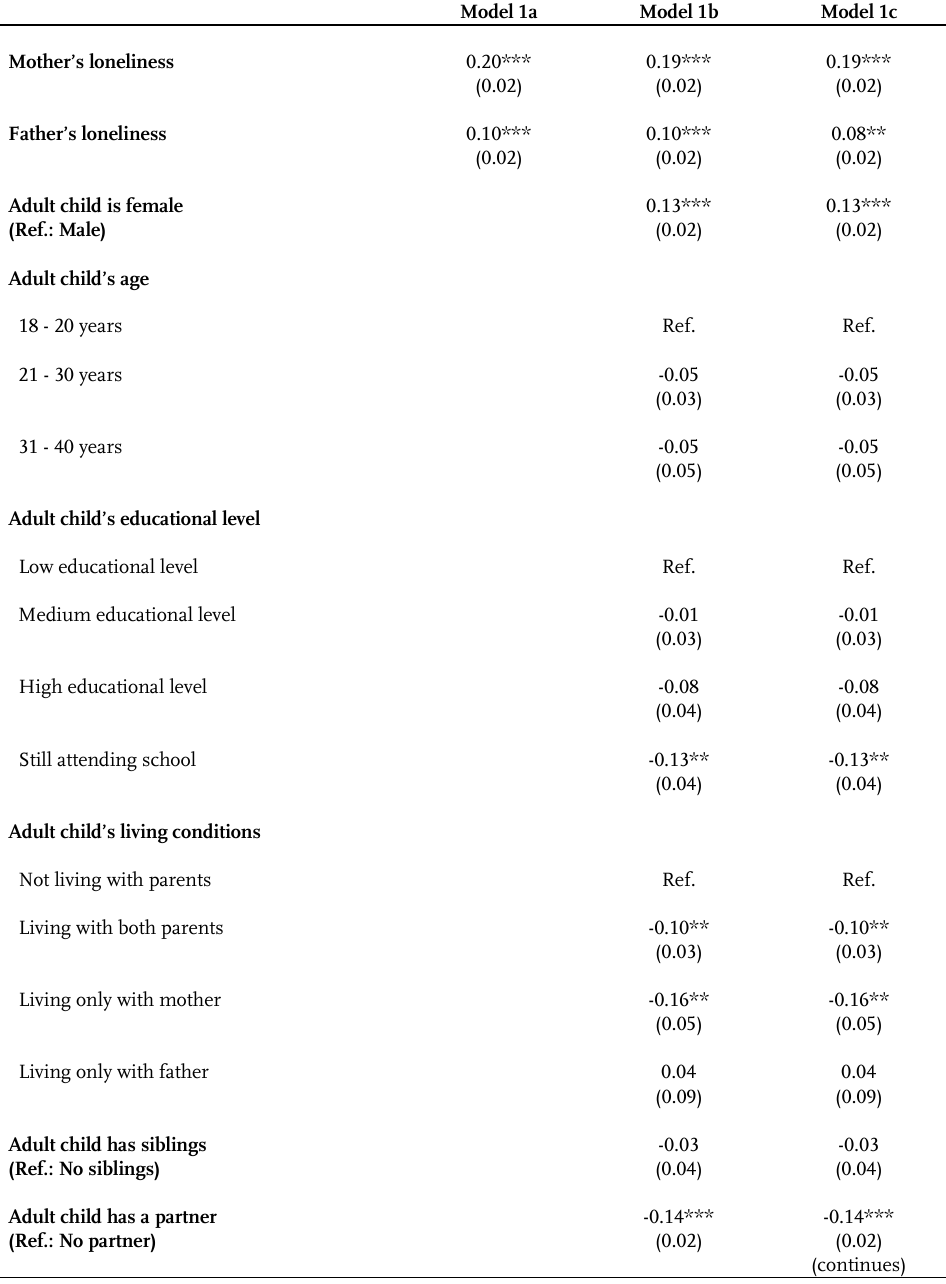
Table 3 : Multilevel regression: The relationship between loneliness in parents and